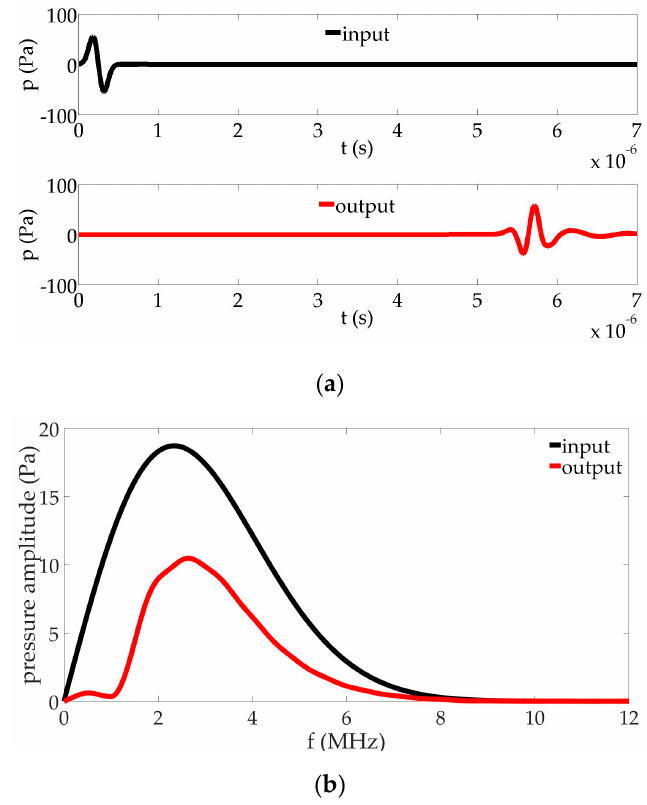
Figure 4. Comparison of input and output signals in the configuration given in Figure 3: ( a ) waveform; ( b ) frequency content.